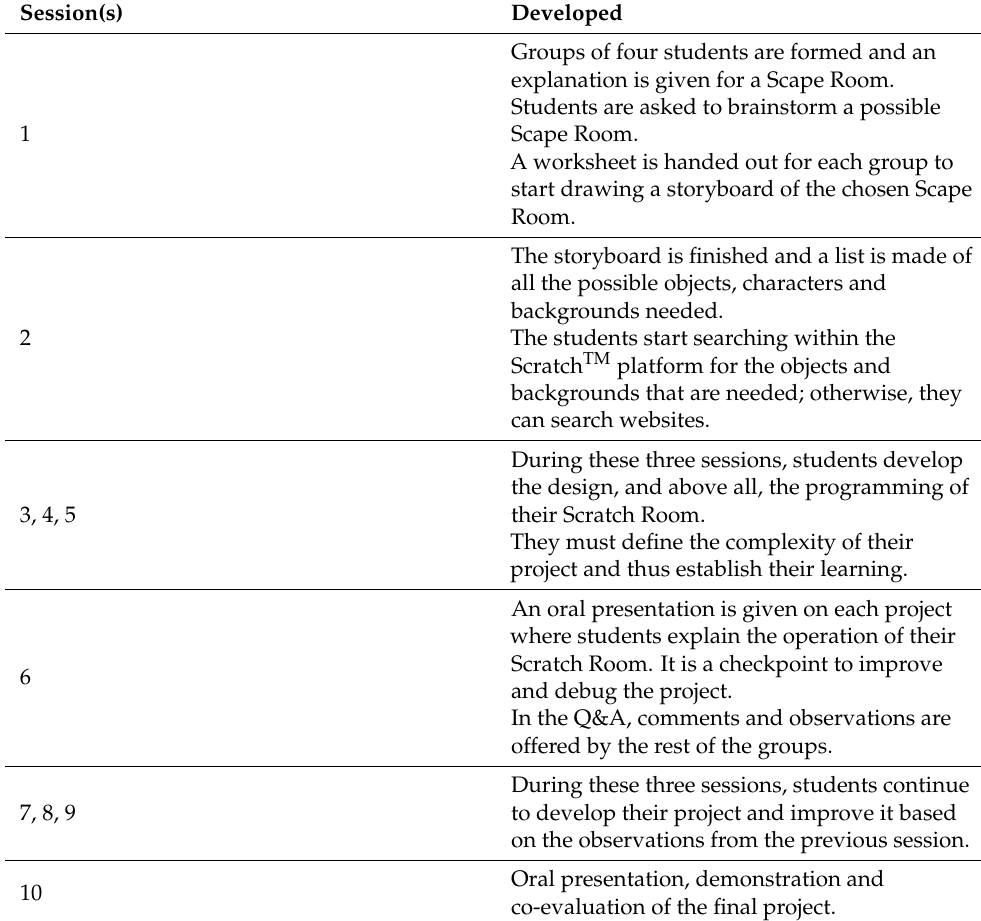
Table 4. Session